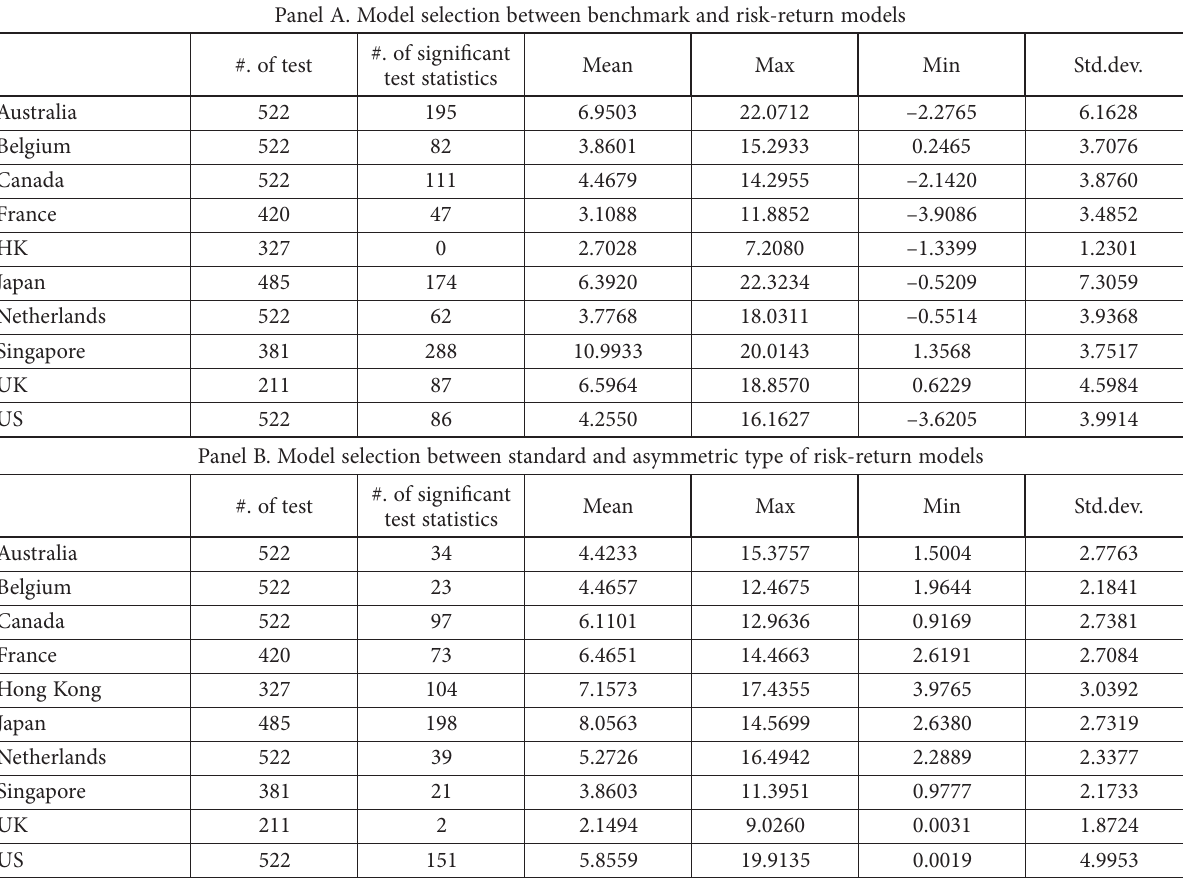
Table 2. Descriptive statistics of the test statistics of likelihood ratio test for 10 REIT markets (weekly data) Panel A. Model selection between benchmark and risk-return models #. of test